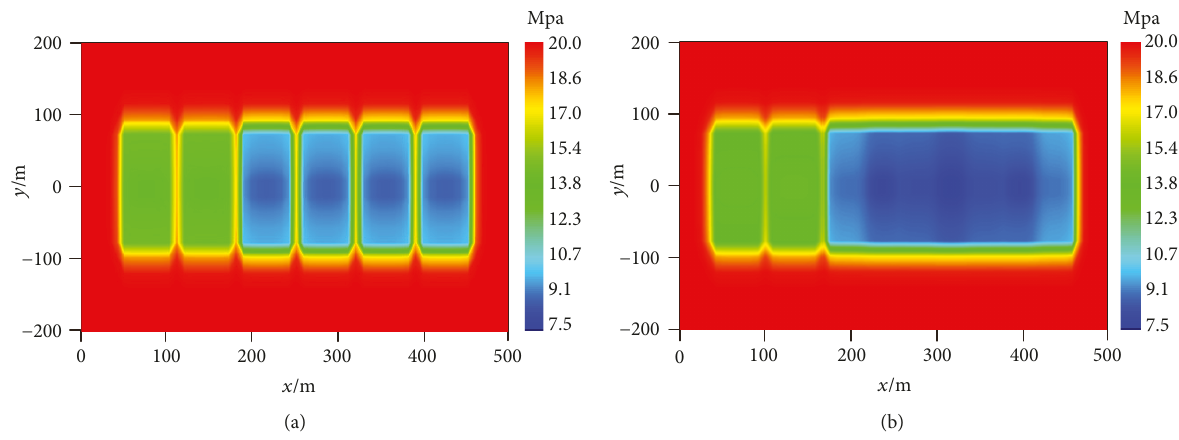
Figure 9: Reservoir pressure distribution: (a) refracturing through existing perforation clusters and (b) refracturing through new perforation zones.